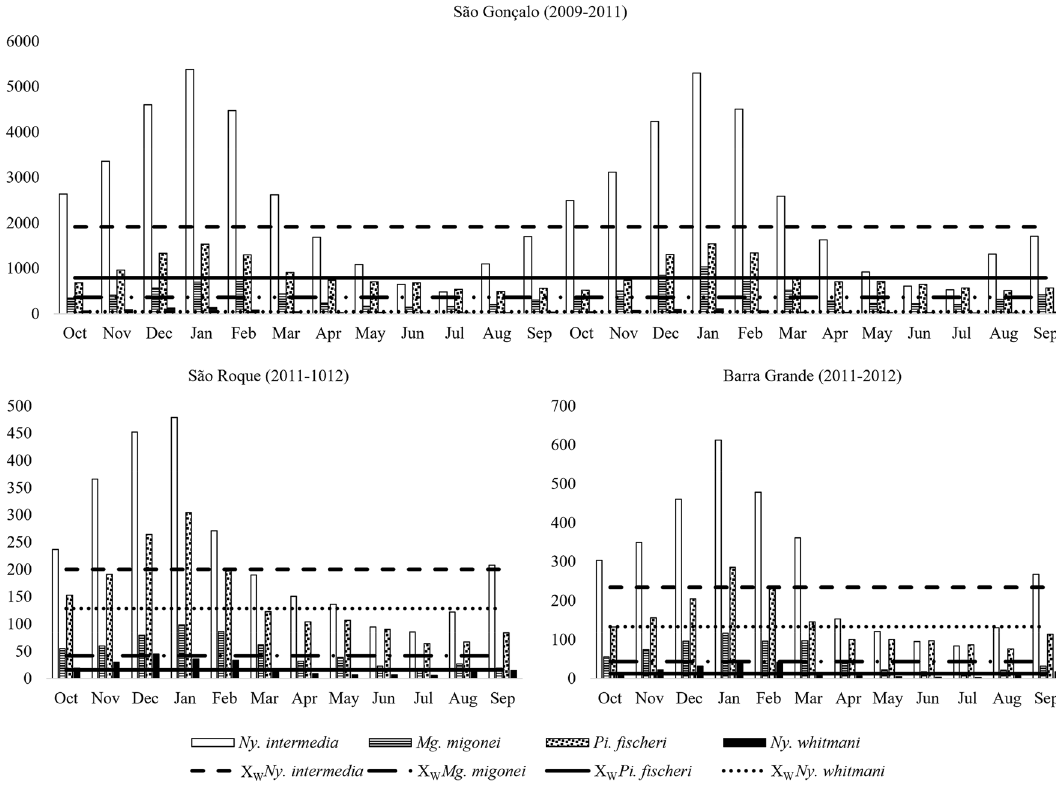
Figure 3. Monthly Frequency and Williams’ Average (X W ) of Sand flies: Nyssomyia intermedia , Migonemyia migonei , Pintomyia fischeri and Nyssomyia whitmani , from October 2009 to September 2012, in the neighborhoods of São Gonçalo, São Roque and Barra Grande, Municipality of Paraty, State of Rio de Janeiro,